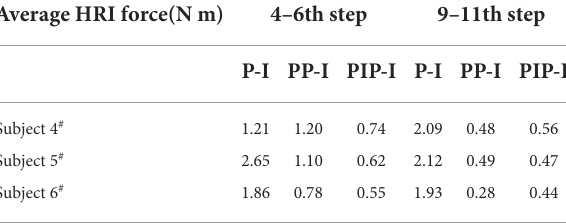
TABLE 1 The comparison of HRI force performance for strategies P-I, PP-I, and PIP-I. Average HRI force(N